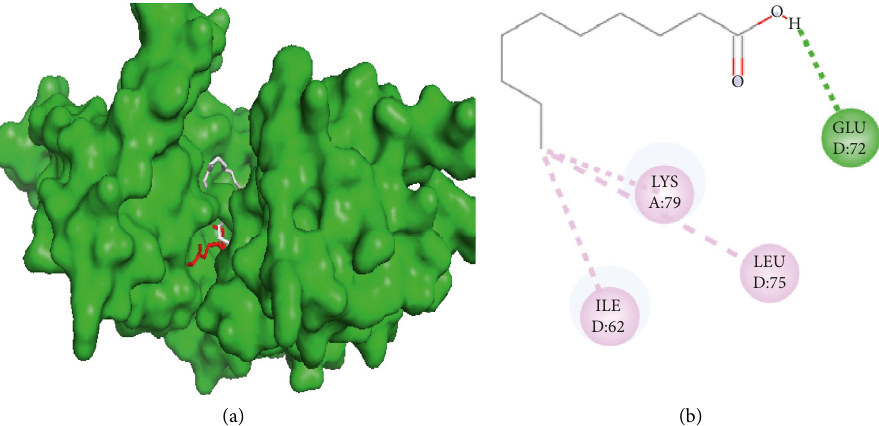
Figure 1: Interaction of capric and palmitic acids with filaggrin. (a) 3D visualization: capric acid (red) and palmitic acid (grey). (b) 2D visualization: amino acid residues in capric acid and palmitic acid.